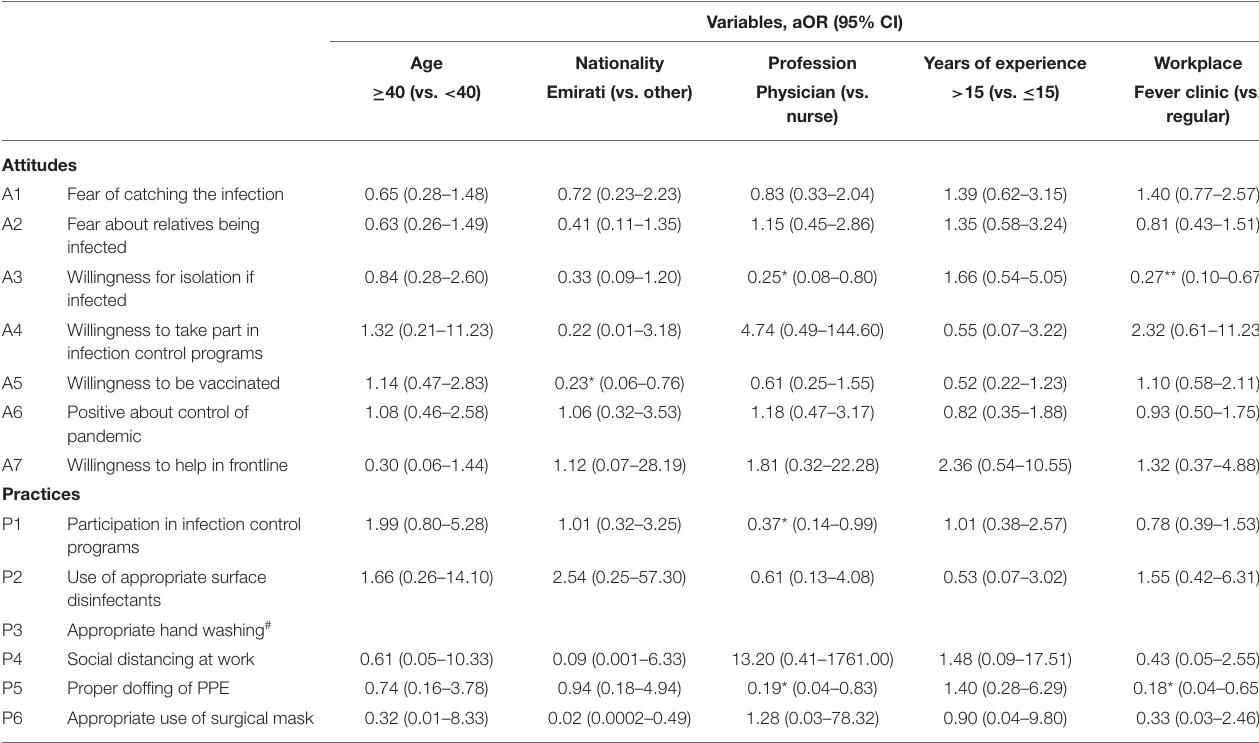
TABLE 5 | Multivariable logistic regression analysis of odds ratio for attitudes and practices of healthcare workers associated with their demographic characteristics ( n = 176).